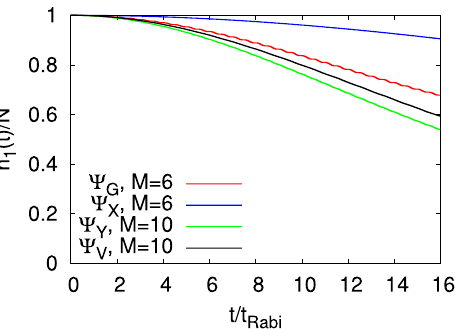
Figure 4. Time-dependent condensate fraction, n 1 ( t )/ N , in a symmetric 2D double-well for the initial states (cid:31) G , (cid:31) X , (cid:31) Y , and (cid:31) V . The number of bosons is N have been obtained by the MCTDHB method with M time-adaptive orbitals for (cid:31) Y and (cid:31) V . See the text for more details. Color codes are explained in the panel. The quantities shown are